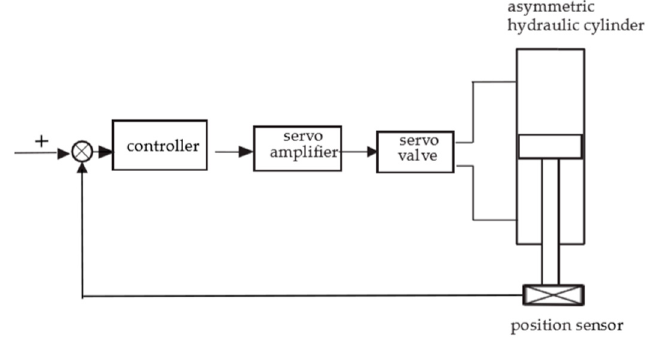
Figure 1. Block diagram of the electro-hydraulic position servo control system.